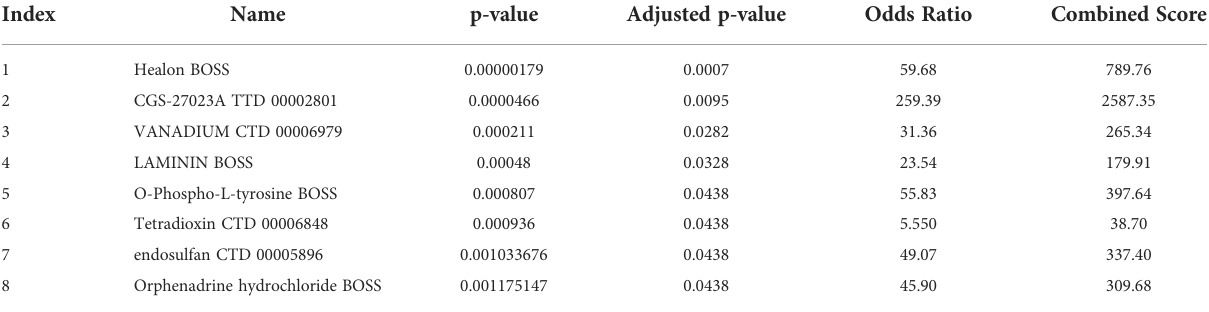
TABLE 2 The eight candidate small molecule drugs predicted based on